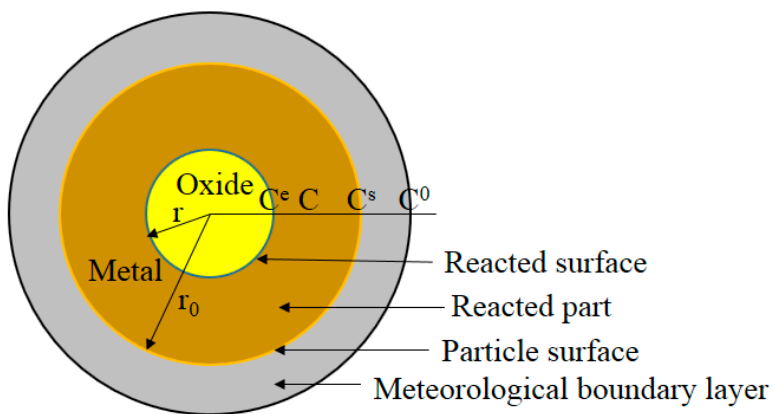
Figure 7. Dynamic model diagram. C 0 , the boundary gas concentration; Cs, the mineral ball surface concentration; C, the chemical reaction interface concentration; C e , the equilibrium concentration of the core interface.